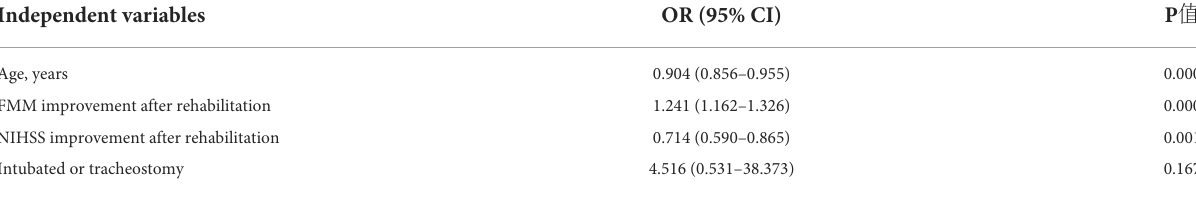
TABLE 3 Prediction Model 1—Multivariate analysis for NGT removal after rehabilitation in PSD patients with overall NIHSS. Independent